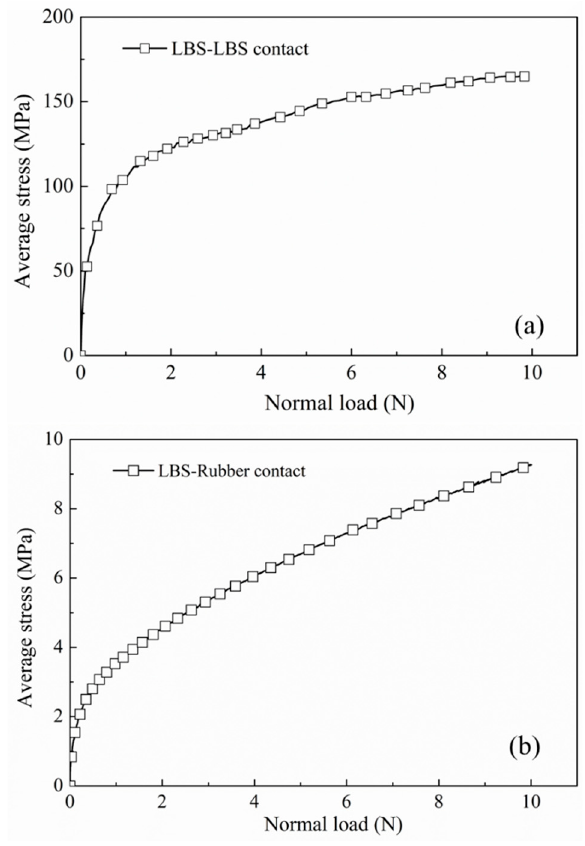
Figure 15. The variation of apparent stress against applied normal load for ( a ) LBS–LBS contact and ( b ) LBS–rubber contact.